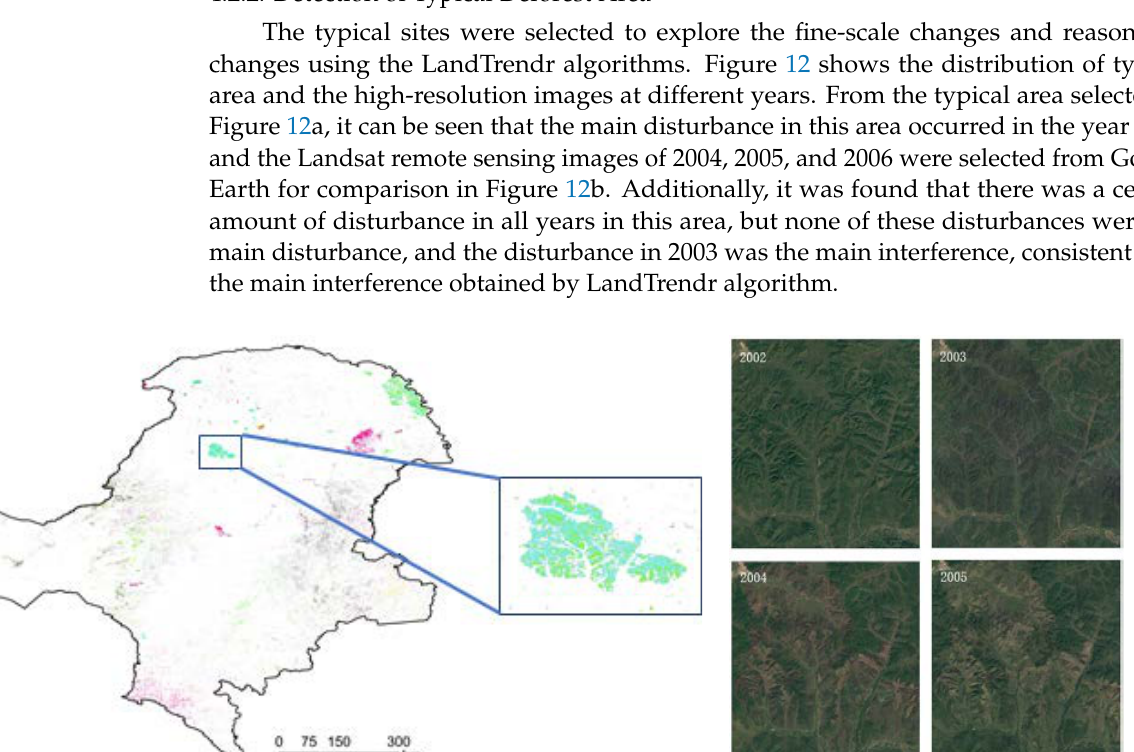
Figure 11. ( a ) Disturbance area and ( b ) duration year, in Great Khingan Mountain (GKM), China.